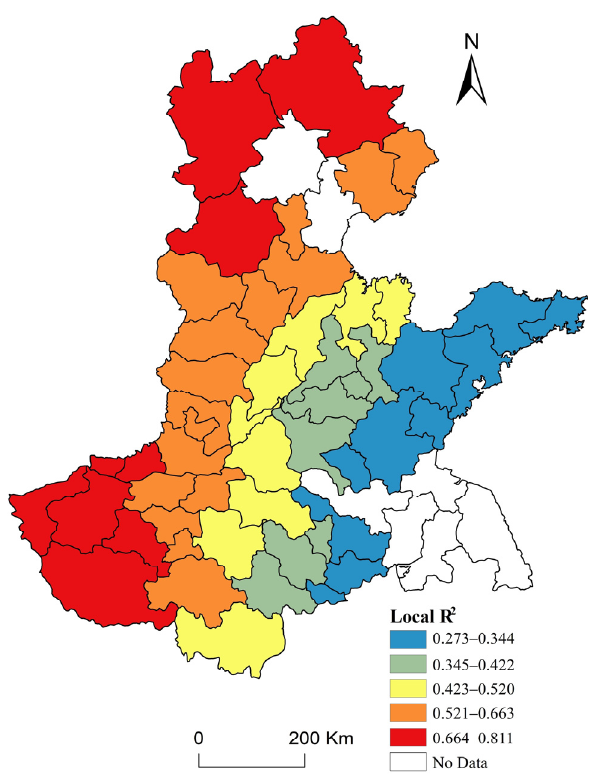
Figure 6. R-squared values derived from the geographical weighted regression (GWR) model.